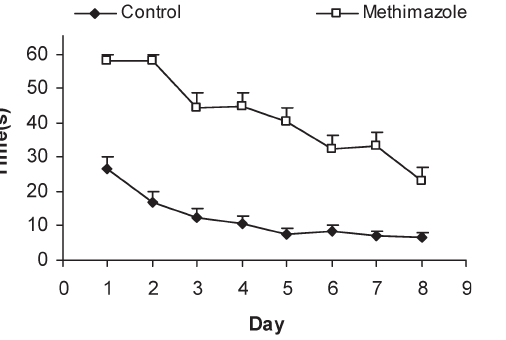
Figure 2 - Comparison of swim time latency (sec) to find the platform between offspring of the methimazole and control groups. The latency was significantly higher in offspring of rats in the methimazole group compared to controls ( P , 0.001). Data are shown as mean ¡ SEM of seven animals per group.